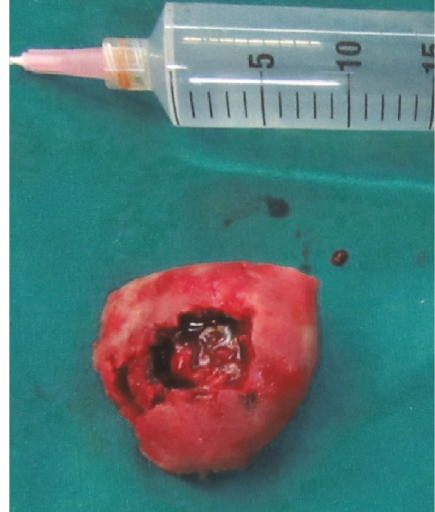
Figure 4: Intraoperative picture showing excised